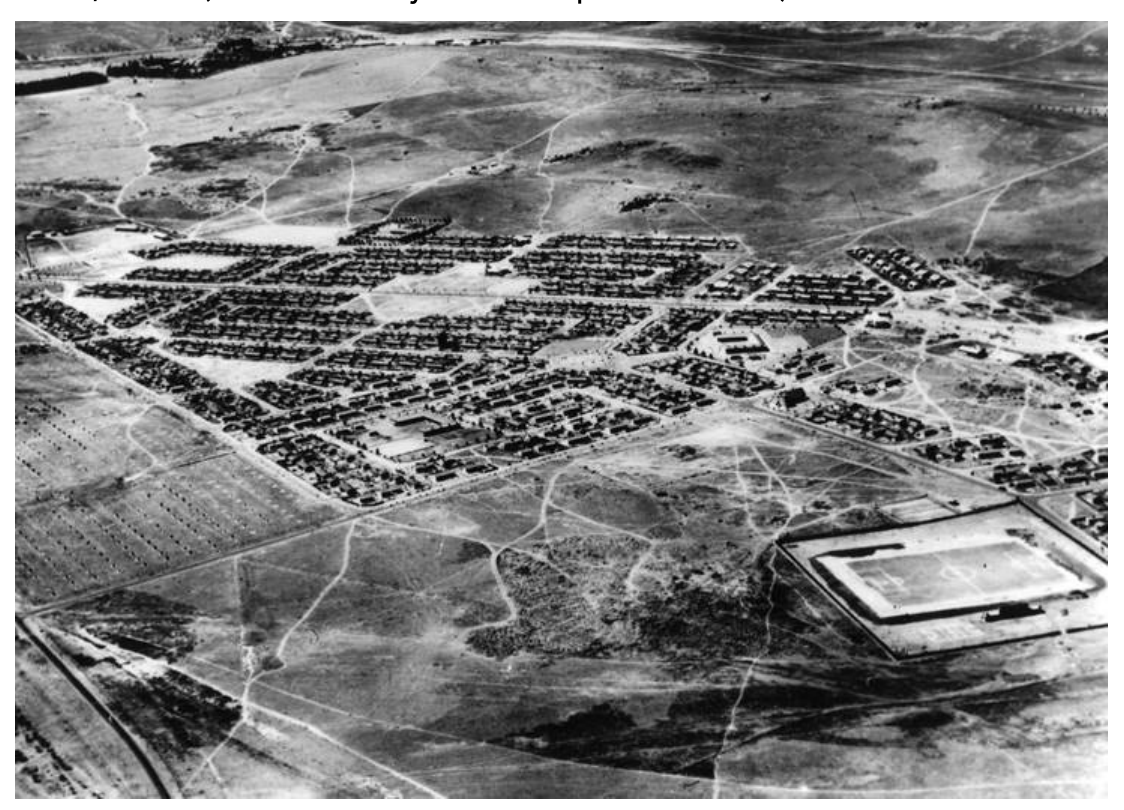
Figure 1. Atteridgeville satellite township, built to house Black inhabitants removed from Pretoria’s suburbs, c . 1945 (Source: University of Pretoria Special